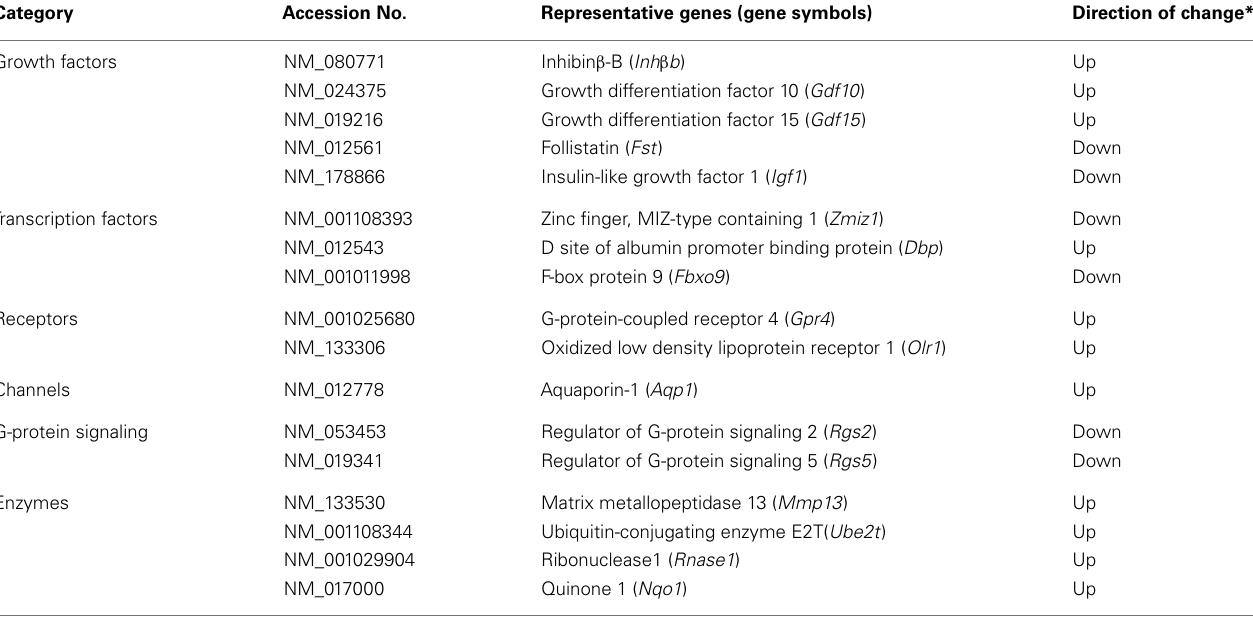
Table 4 | Representative genes altered with fold change as revealed by DNA microarray.